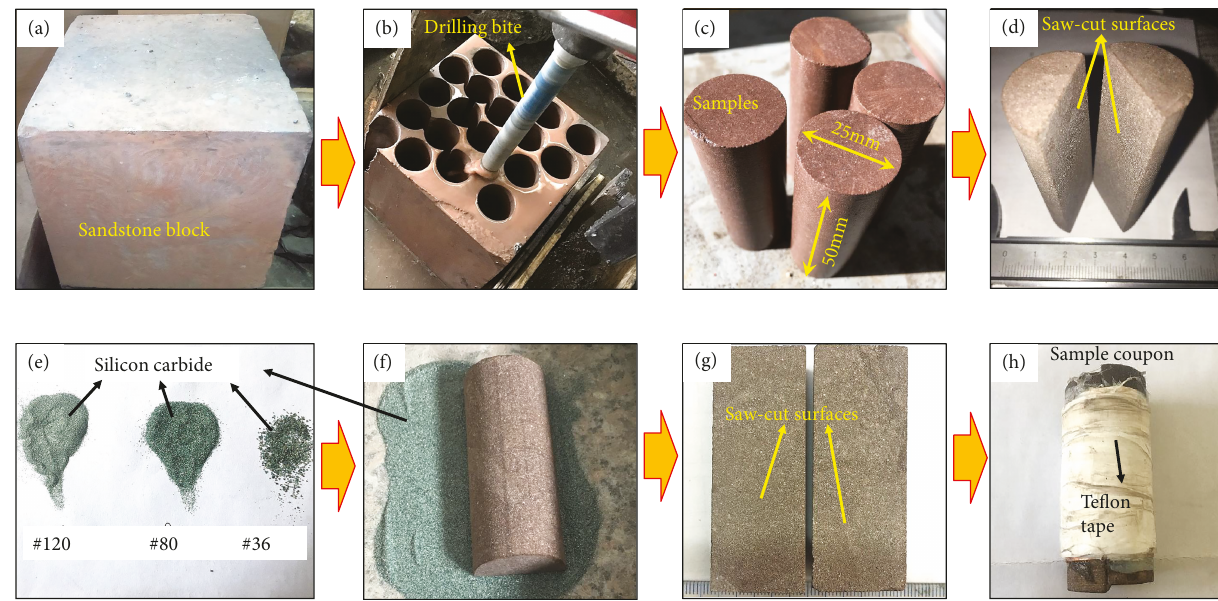
Figure 1: Sample preparation: (a) sandstone block; (b) coring; (c) cylinders with the diameter of 25mm and the height of 50 mm; (d) halved semicylindrical samples; (e) #120 Grit, #80 Grit, and #36 Grit (a lower value implies a coarser silicon carbide powder, thus implying a rougher surface); (f) grinding the planar surfaces by silicon carbide powder; (g) ground surfaces; (h) combining the specimen by Te fl on